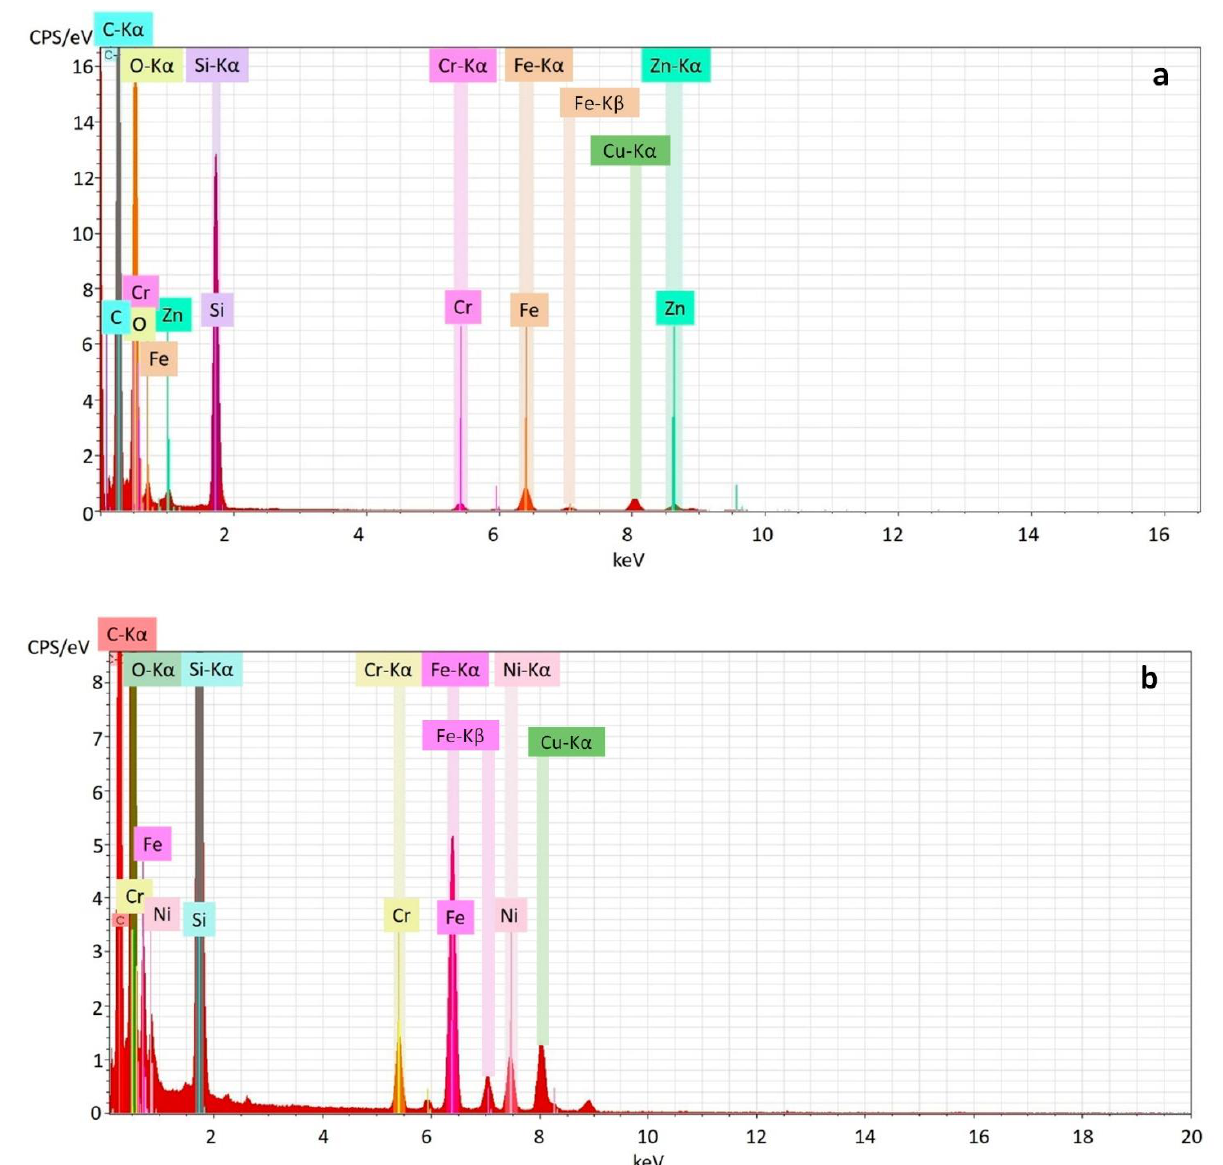
Figure 3. EDS spectra of SiO 2 -Fe 3 O 4 -PPP-Cr-Zn ( a ) and SiO 2 -Fe 3 O 4 -PPP-Cr-Ni ( b ) nanocomposites. Cu-Kα signals are presented due to Cu-grid used for recording of the spectra.